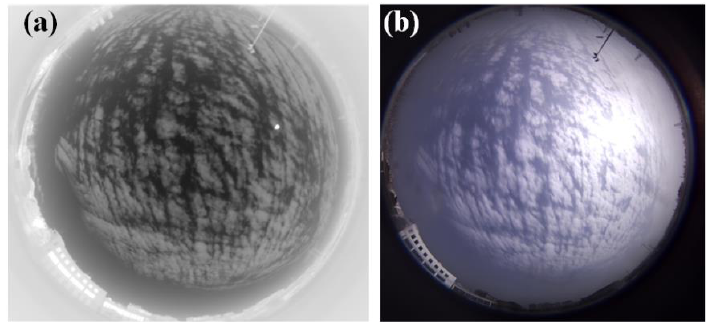
Figure 1. (a) All-sky camera 200 (ASC-200) and (b) ASC-200 in the meteorological observation sta- tion.